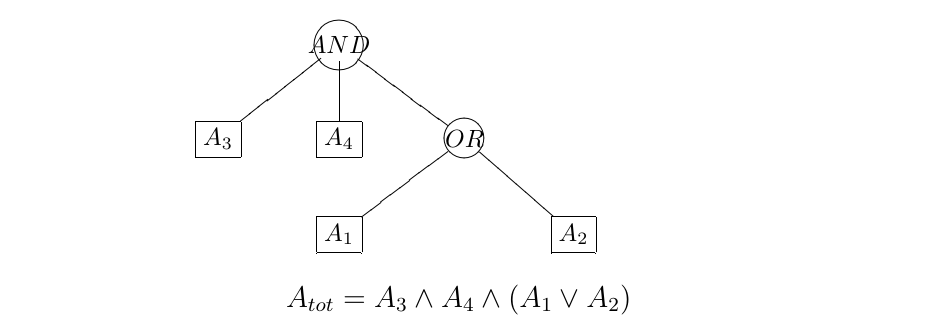
Figure 5. A simple example of availability calculations. The isAvailable attribute of depending objects in the inner sample loop is the Boolean result of such a